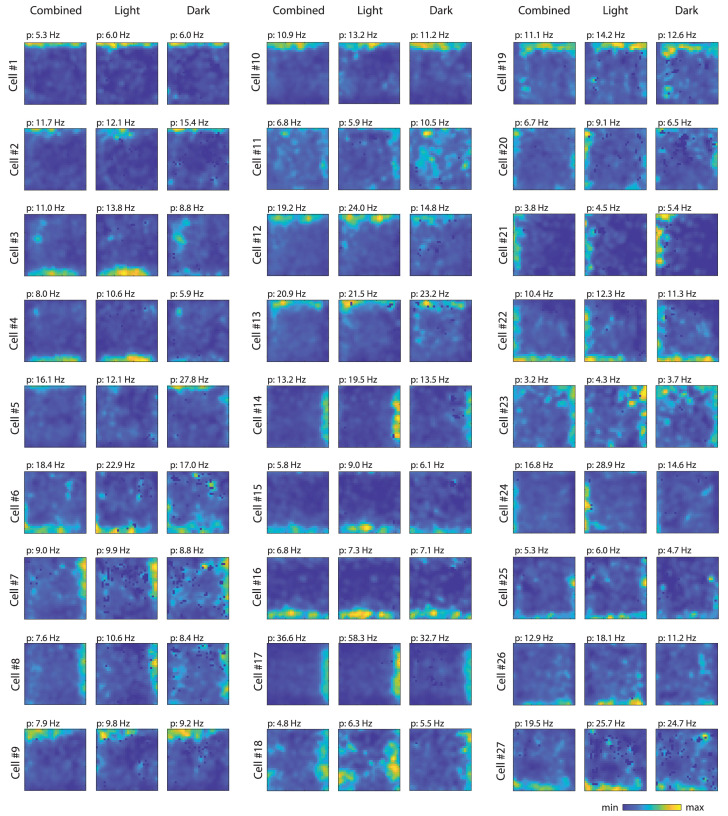
Firing rate maps for the 27 border cells identified in this study.For each cell, first panel shows the firing rate map from the whole recording session (light and dark epochs combined), second panel shows the firing rate map from the light condition, and third panel shows the firing rate map from the dark condition. For each cell, the same color scale was used across conditions; p=peak firing rate.